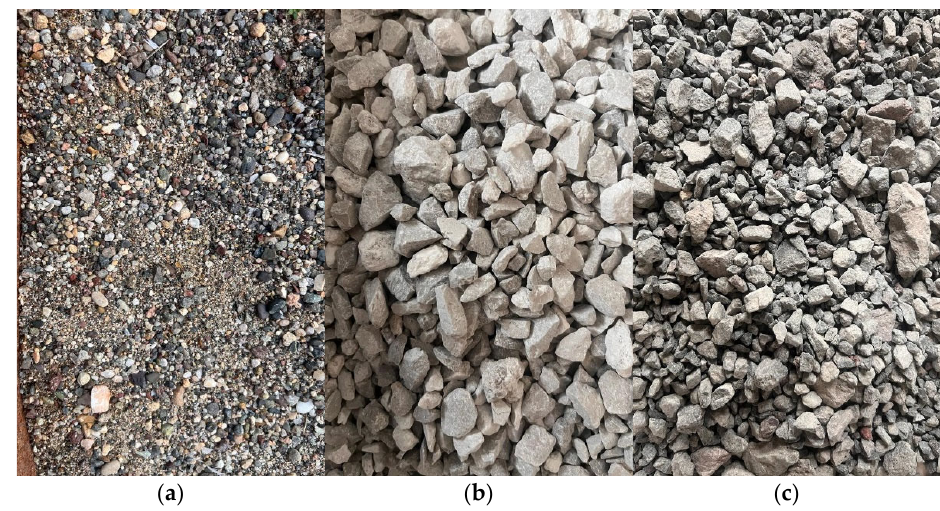
Figure 2. ( a ) Natural sand, ( b ) Crushed stone and ( c ) WB.